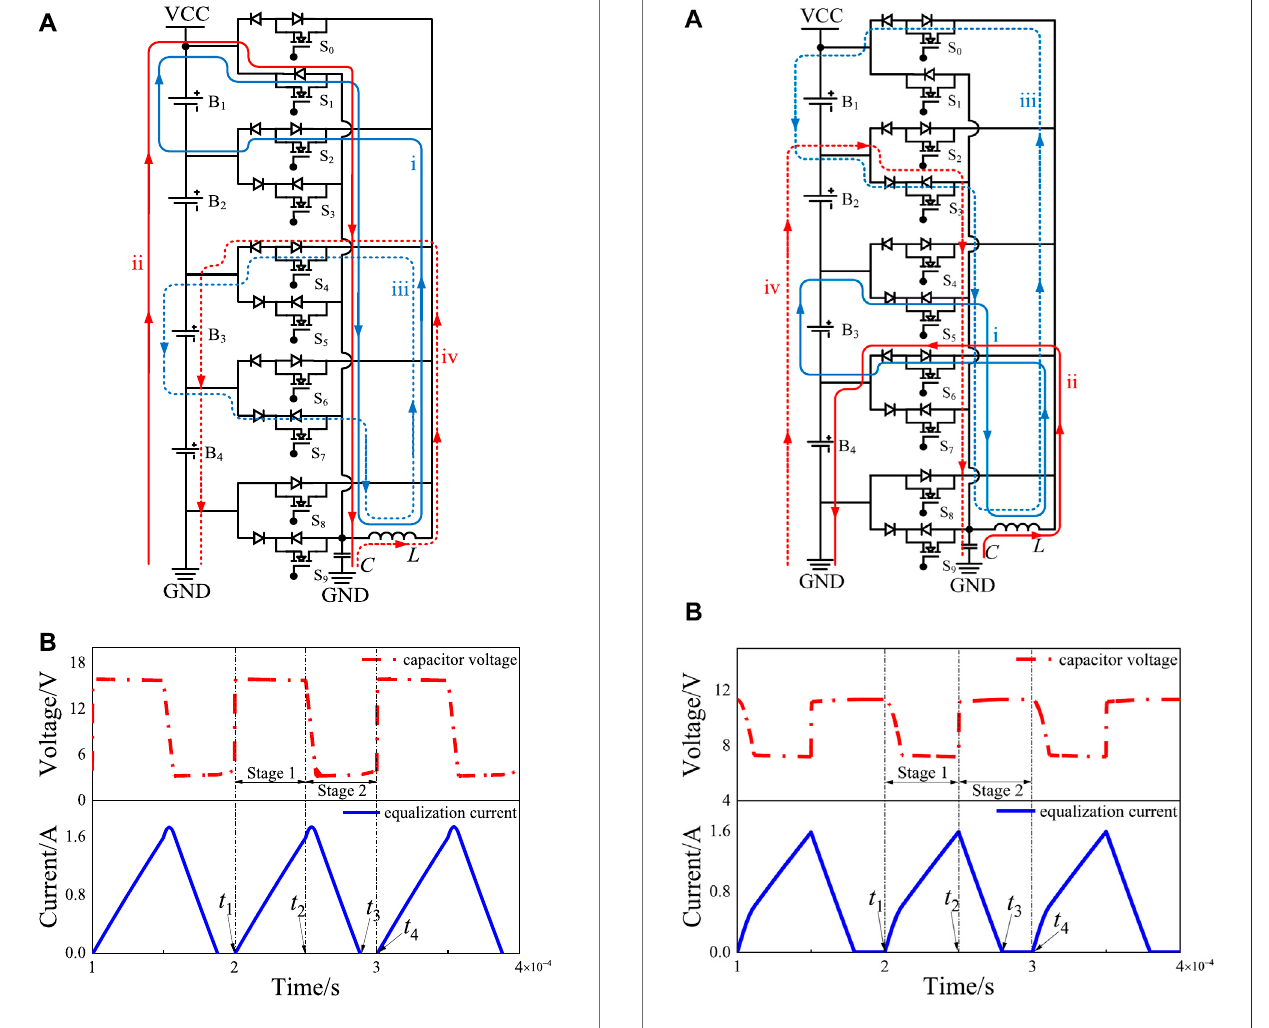
FIGURE 3 | The working principle of the power of B 3 is the highest, and B 1 is the lowest. (A) Balancing current loops. (B) Waveforms of the balancing current and capacitor